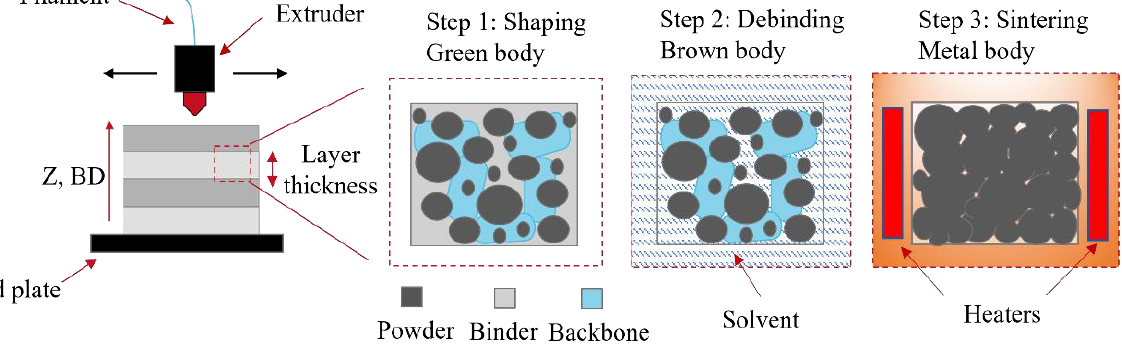
Figure 1. Illustration of the FFF processing steps to produce dense metal or ceramic parts.